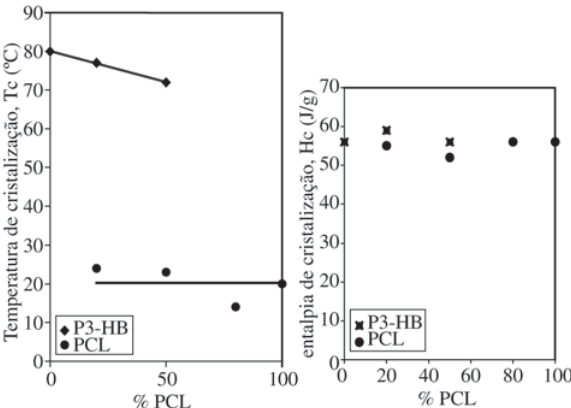
Figura 5. a) Temperaturas de cristalização do P(3-HB) e da PCL em função da % de PCL na blenda; b) Entalpias de cristalização do P(3-HB) e da PCL em função da % de PCL na blenda.